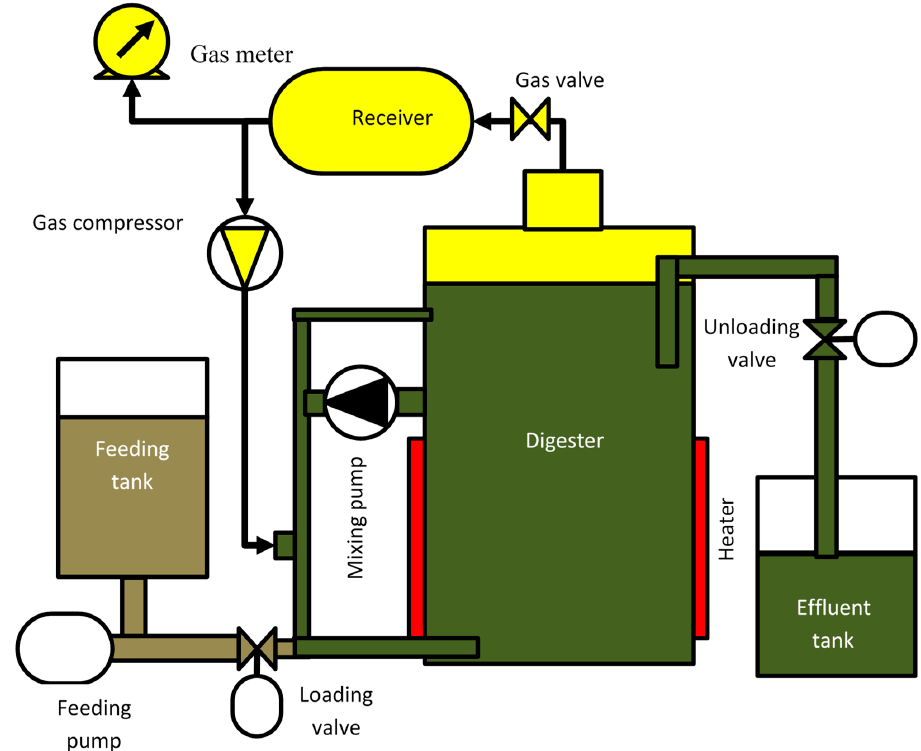
Figure 2. Schematic diagram of the experimental semipilot AD plant.